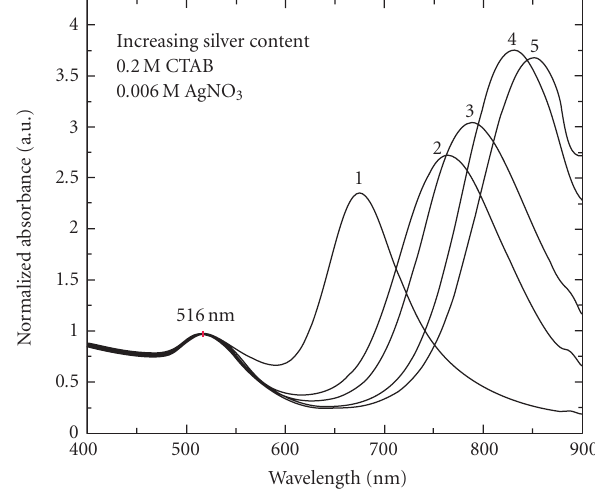
Figure 5: Normalized extinction spectra of gold nanorods with in- creasingly red-shifted longitudinal plasmon bands, synthesized us- ing 50, 100, 150, 200, and 250 μ L of silver nitrate in the growth so- lution for curves 1–5, respectively. Normalization of the spectra is done with respect to the transverse plasmon peak